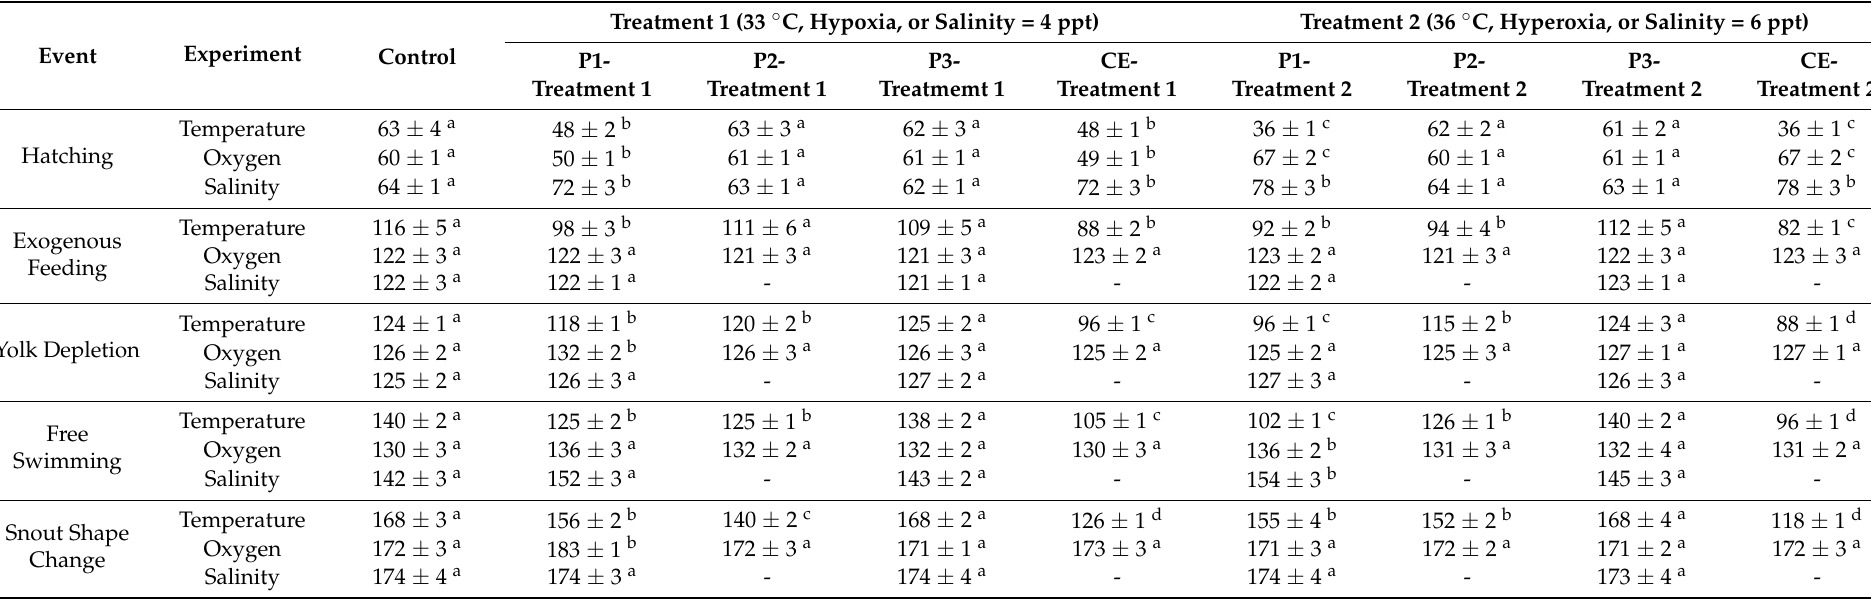
Table 1. Time of occurrence (hours post fertilization) of key developmental events in Atractosteus tropicus . Significant differences between groups from every experiment for time to hatching, exogenous feeding, yolk depletion, free swimming, and mouth opening are denoted by lowercase letters. Mean ± SD are presented. n = 30 fish per